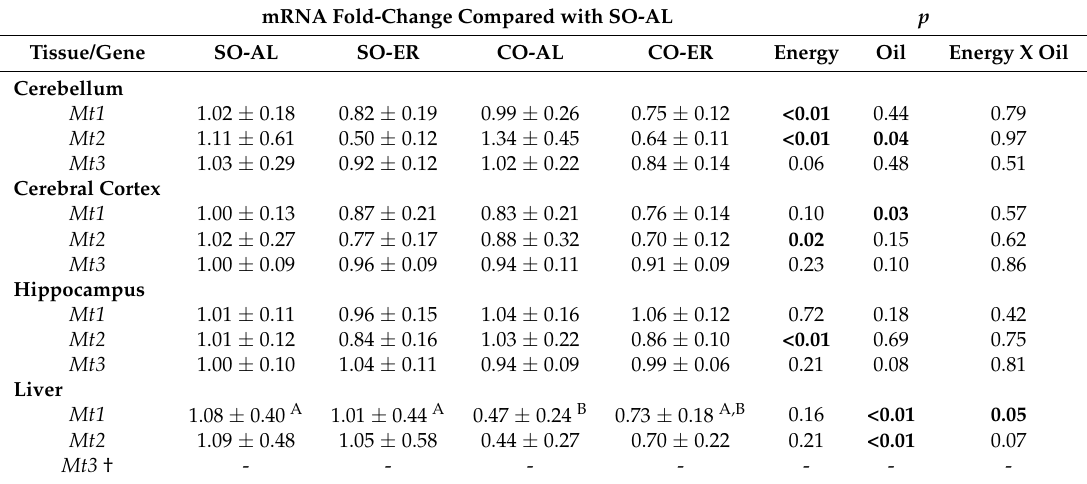
Table 2. Tissue expression of metallothionein